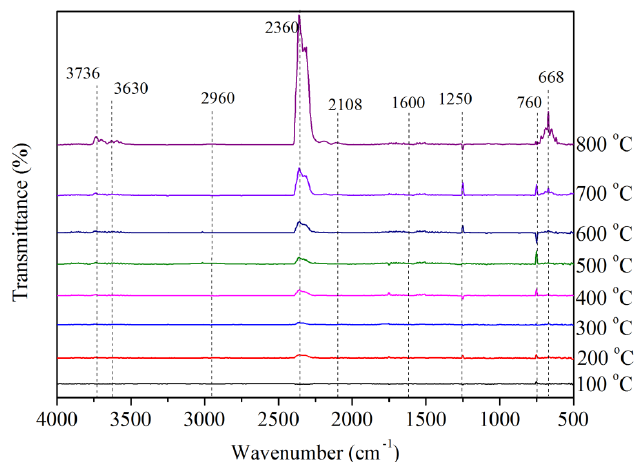
Figure 6. TG-FTIR spectra of FR-PVA/PAN of gaseous ingredients during the thermal decomposition at different temperatures.